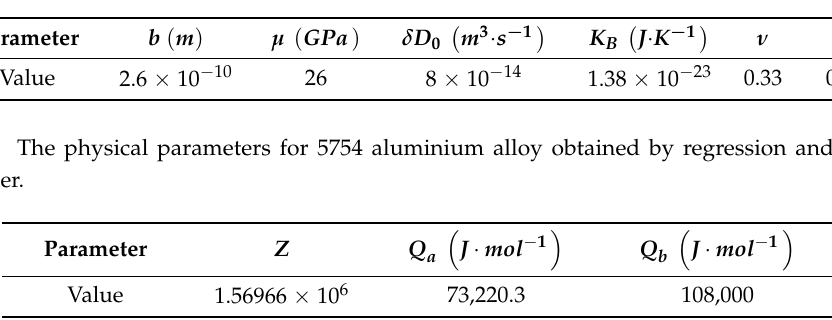
Table 2. The material constants of 5754 aluminium alloy in this paper.